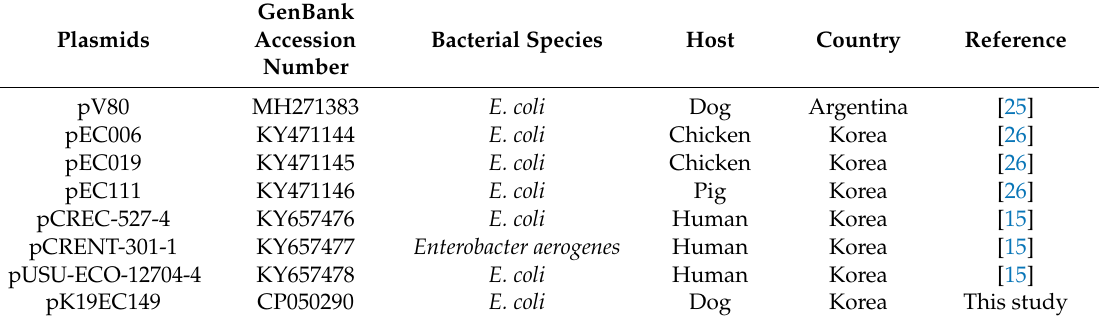
Table 1. Lists of plasmids identified in isolates recovered from humans, dogs, and food animals.